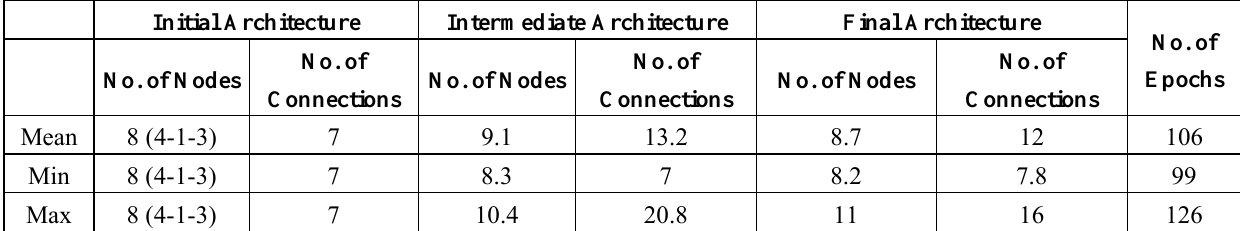
Table 8. ANN architectures and the training epochs for the lenses dataset.